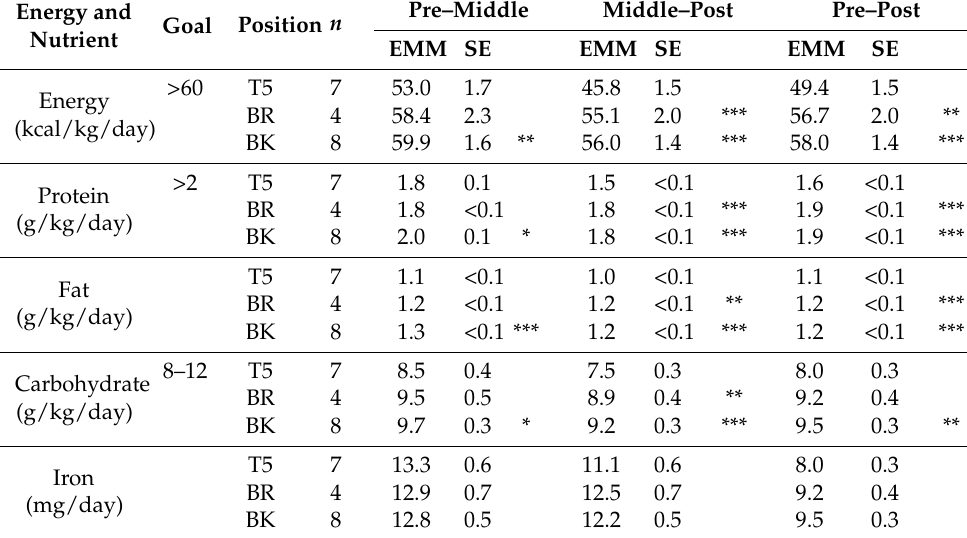
Table 2. Energy, energy source, and iron intake during the study